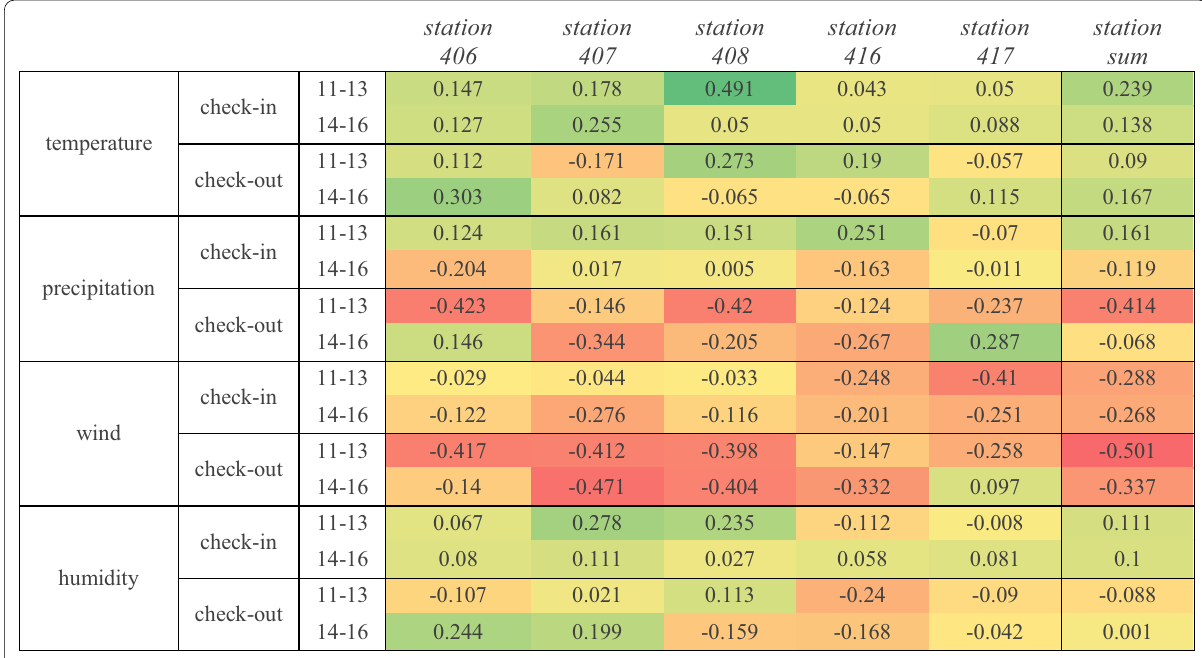
Fig. 13 Pearson correlation between the weather data and the check-ins and check-outs at GIRA bike stations for intervals of 2 h in a day (11 h to